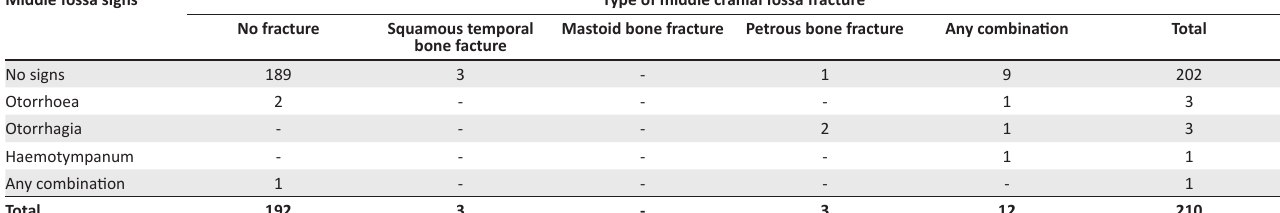
TABLE 2: Comparison of middle cranial fossa clinical signs and fractures on computed tomography ( n = 210). Middle fossa signs